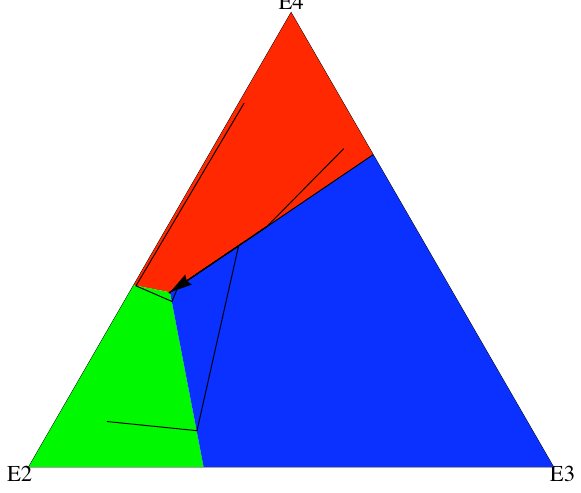
Figure 1. Sufficiently close to the line segment s , the dynamics is similar to the dynamics for the restricted game A | . Every orbit hits the set B 24 , shown by the arrow in the 234 figure. Inside this set there is a forced movement towards the unique Nash equilibrium of the restricted game.